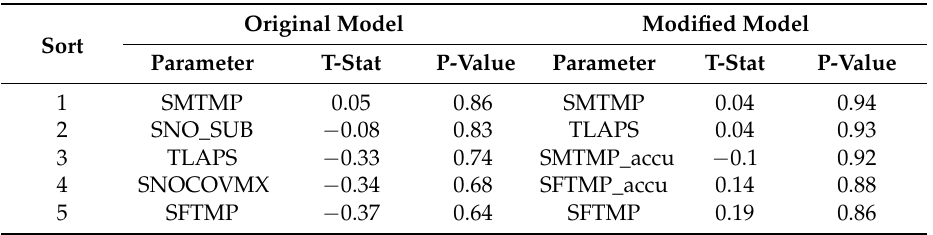
Table 4. Parameters used in the sensitivity analysis and the sensitivity analysis results, the